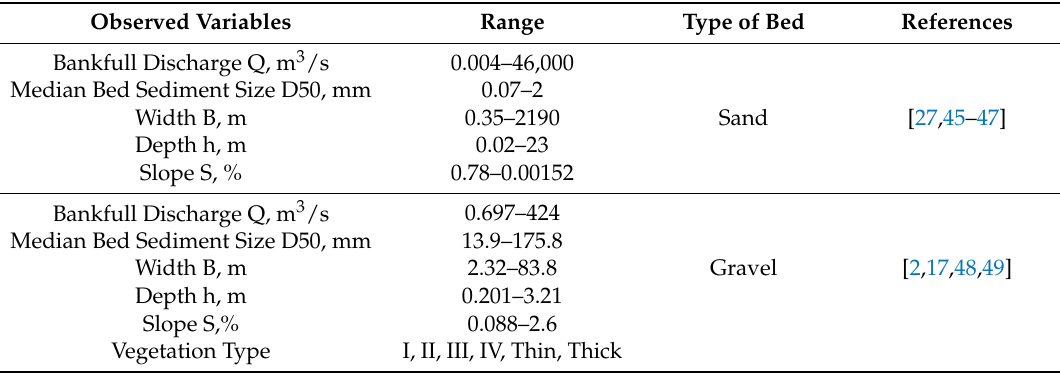
Table 1. Description of the Regime